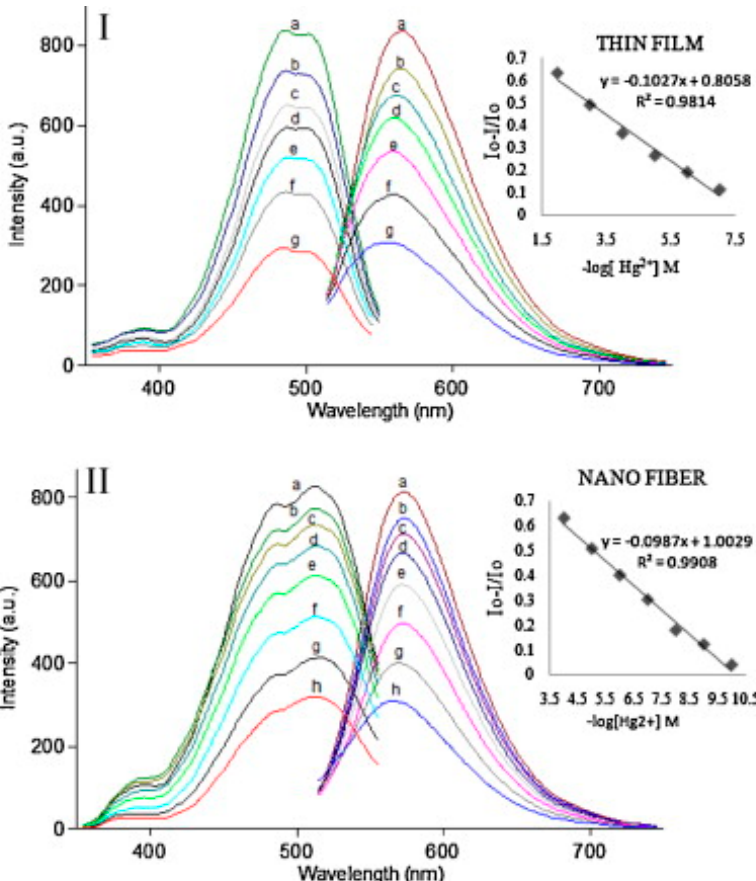
Figure 2. (I) Fluorescence response of the DC-AZM-doped, EC-based thin film to Hg (II) ions at pH 4.0. (a) Hg-free buffer, (b) 10 − 7 , (c) 10 − 6 , (d) 10 − 5 , (e) 10 − 4 , (f) 10 − 3 , and (g) 10 − 2 M Hg (II). Inset: calibration plot for the concentration range of 10 − 7 –10 − 2 M Hg (II). ( II ) Response of the EC based nanofiber to Hg (II) ions at pH 4.0. (a) Hg-free buffer, (b) 10 − 10 , (c) 10 − 9 , (d) 10 − 8 , (e) 10 − 7 , (f) 10 − 6 , (g) 10 − 5 , and (h) 10 − 4 M Hg (II). Inset: linearized calibration plot for the concentration range of 10 − 10 –10 − 4 M Hg (II). Reprinted with permission from [39]. Copyright 2012, Elsevier.